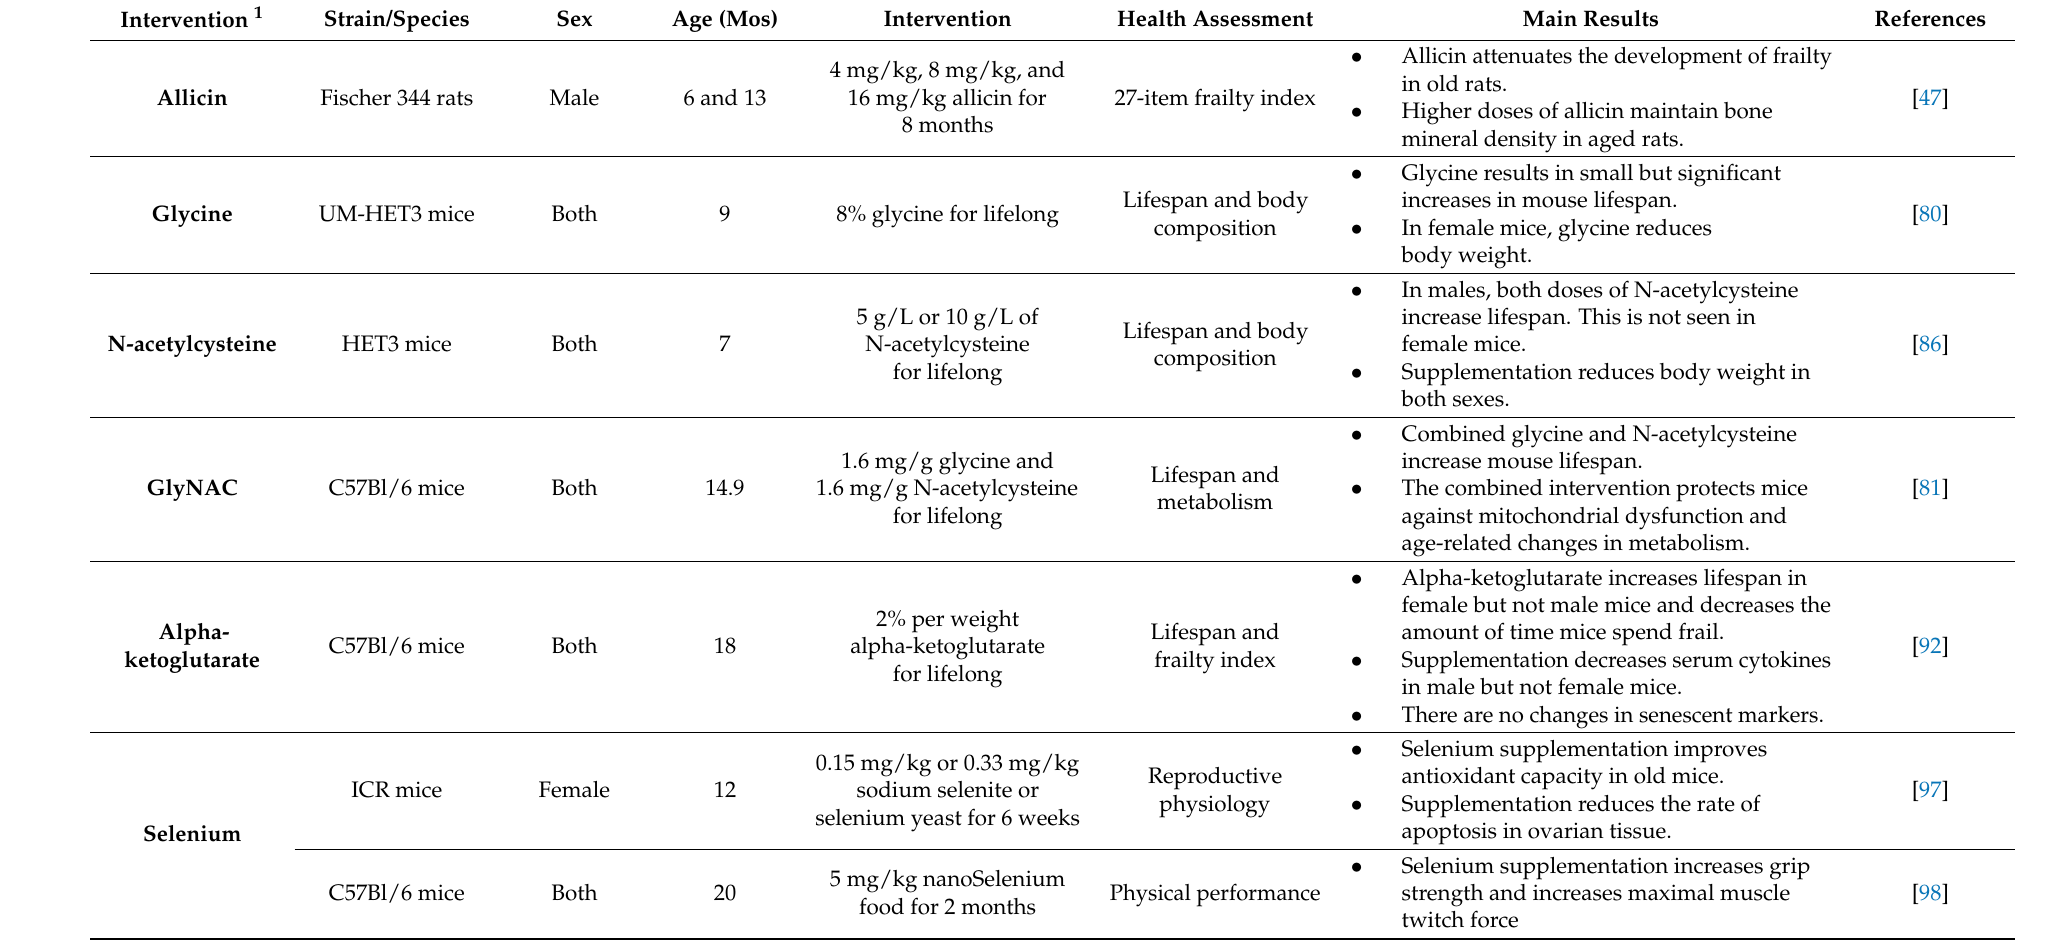
Table 2. Other supplement interventions to improve overall health and attenuate